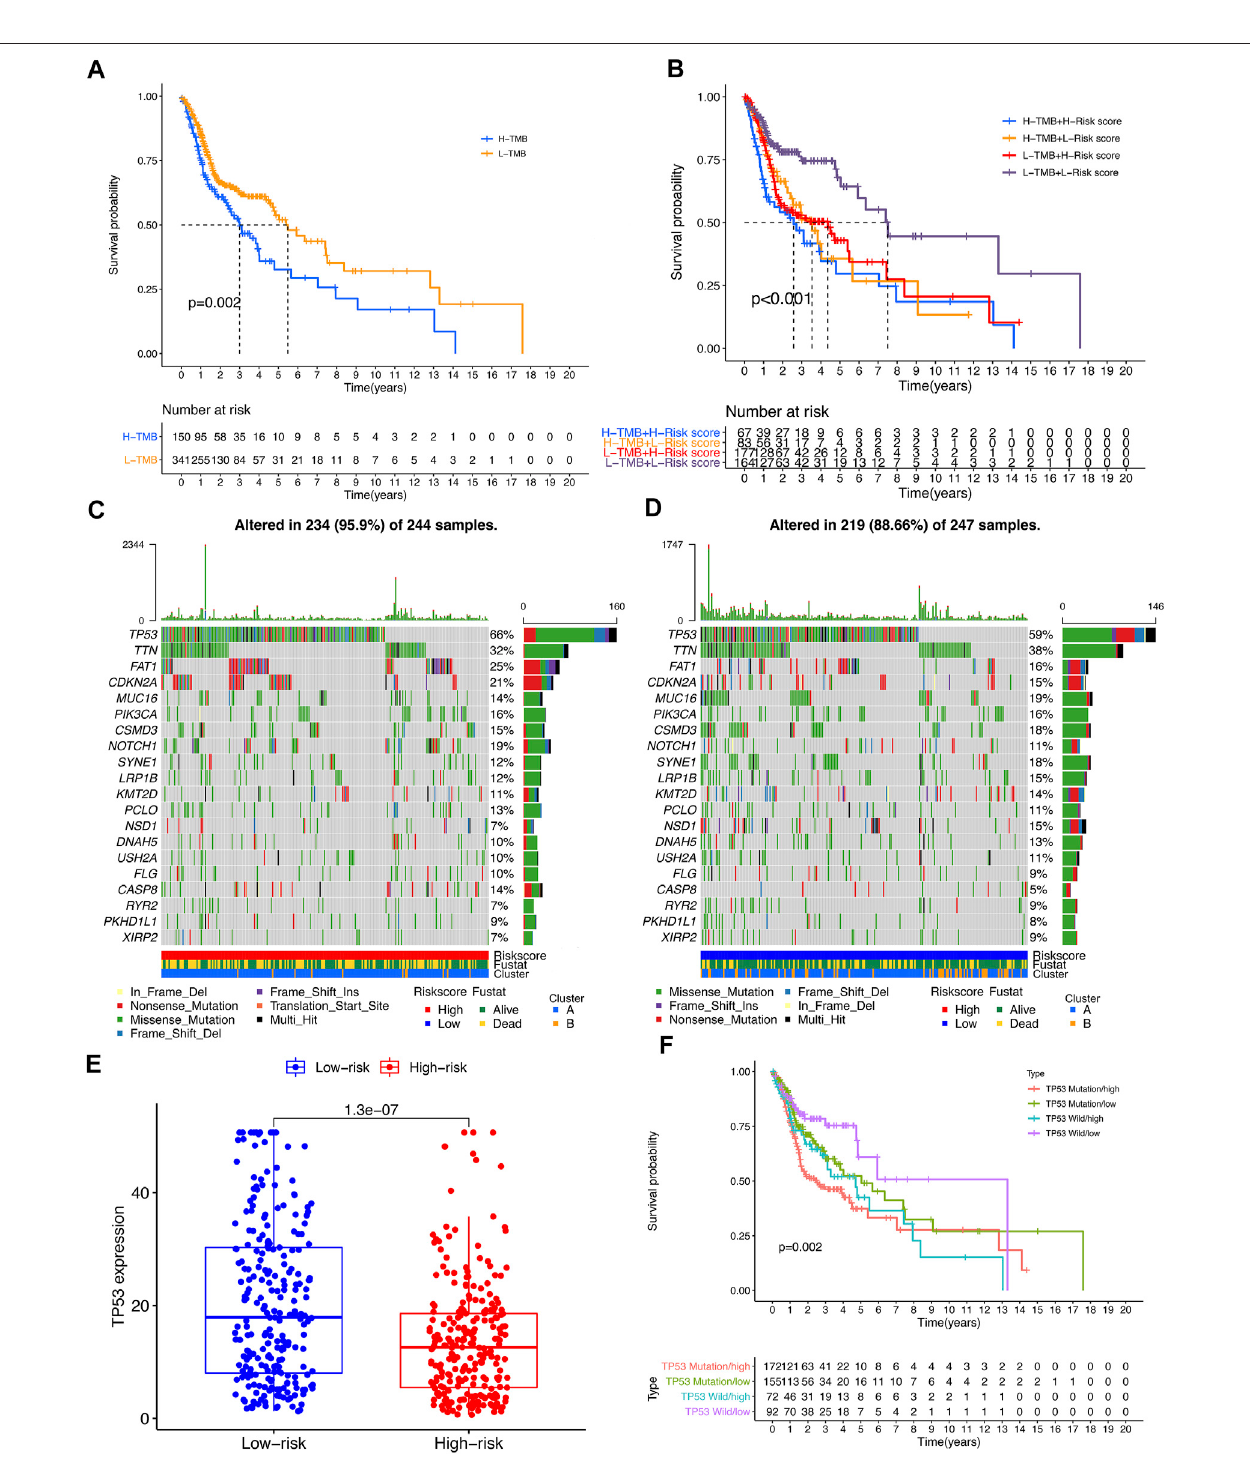
FIGURE7| TheimpactofdifferentialTMBlevelonpatients ’ prognosisandTP53somaticmutation. (A) ComparisonofprognosisbetweenhighTMBsubgroupand low TMB subgroup. (B) Comparison of prognosis of TMB combined with risk score. (C,D) Top 20 genes with the most signi fi cant mutation rates in high-risk subgroup and low-risk subgroup. (E) The differential expression level TP53 between high-risk group and low-risk group. (F) Kaplan – Meier curve analysis of overall survival was shown forpatientsclassi fi edaccordingtoTP53mutation status andriskscore. TP53-wt: wildtype ofTP53sequence; TP53-mt:mutationtype ofTP53sequence.